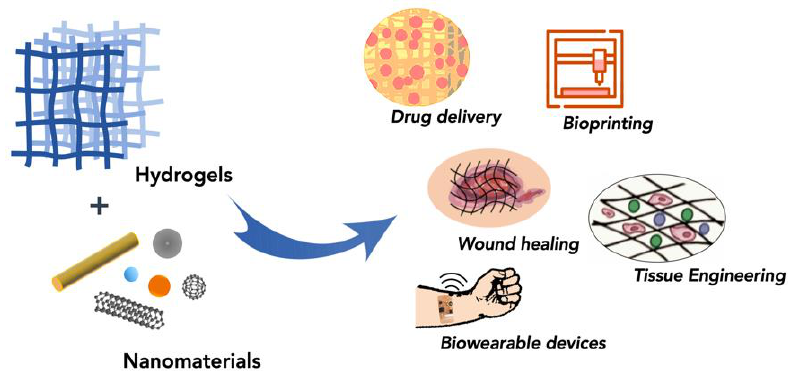
Figure 1. Schematic showing the broad applicability of hydrogel nanocomposites in the biomedi- cal industry.